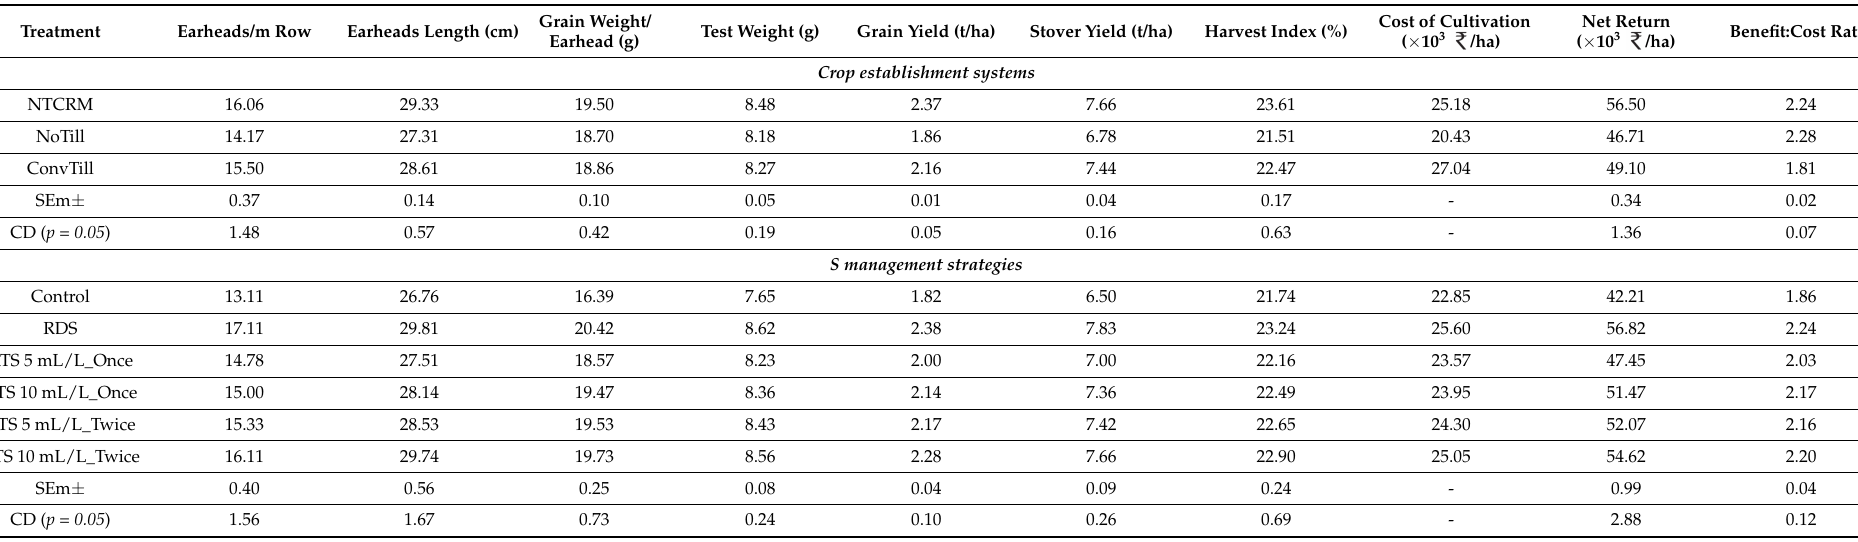
Table 2. Effect of crop establishment system and sulphur nutrition levels on yield attributes, yield and economics of pearl millet (mean of 2 years data).